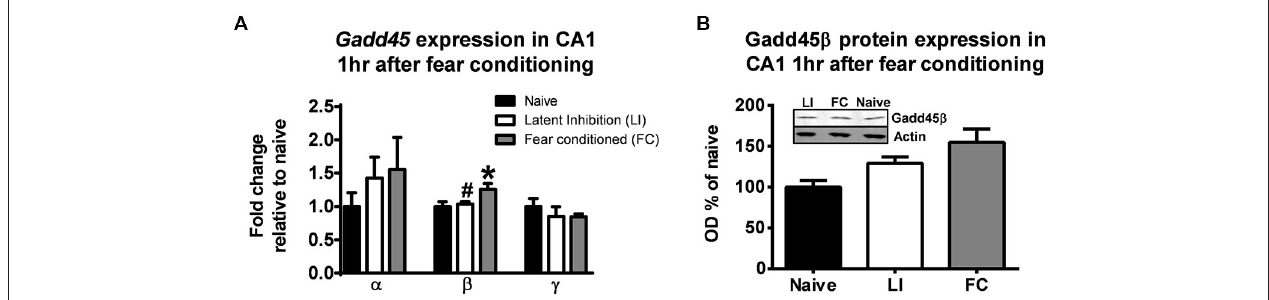
FIGURE 1 | Gadd45 β expression is increased in the hippocampus following learning. (A) Animals were trained to contextual fear conditioning and area CA1 collected 1 h later (Fear conditioned). A separate group of animals was exposed to the training context for 2 h, followed by the same contextual fear conditioning procedure and area CA1 collected 1 h later (Latent Inhibition). Quantitative RT-PCR revealed an increase in Gadd45 β , but not Gadd45 α or Gadd45 γ , gene expression in area CA1 following fear conditioning ( n = 5–6 per group). (B) Western blot analysis confirmed a moderate increase in Gadd45 β protein expression